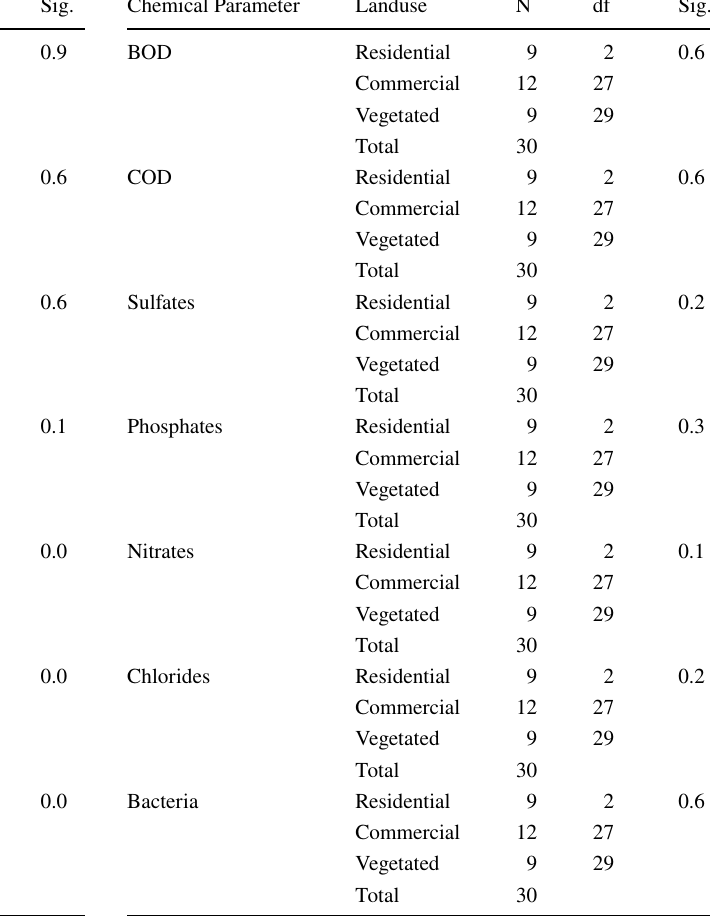
Table 4 Variation in the chemical parameters of surface water and the landuse types. Source : Author’s fieldwork